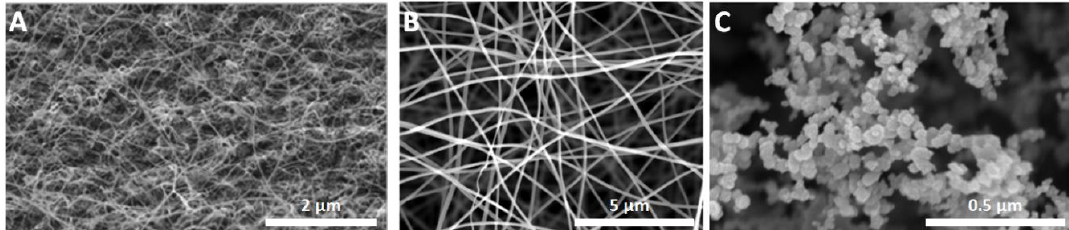
Figure 2. SEM pictures of: carbon nanotubes (CNTs) ( A ); carbon nanofibers (CNFs) ( B ); and candle